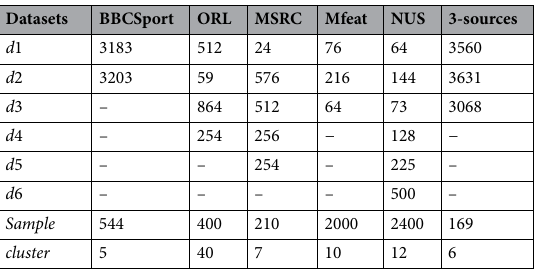
Table 1. Information about six